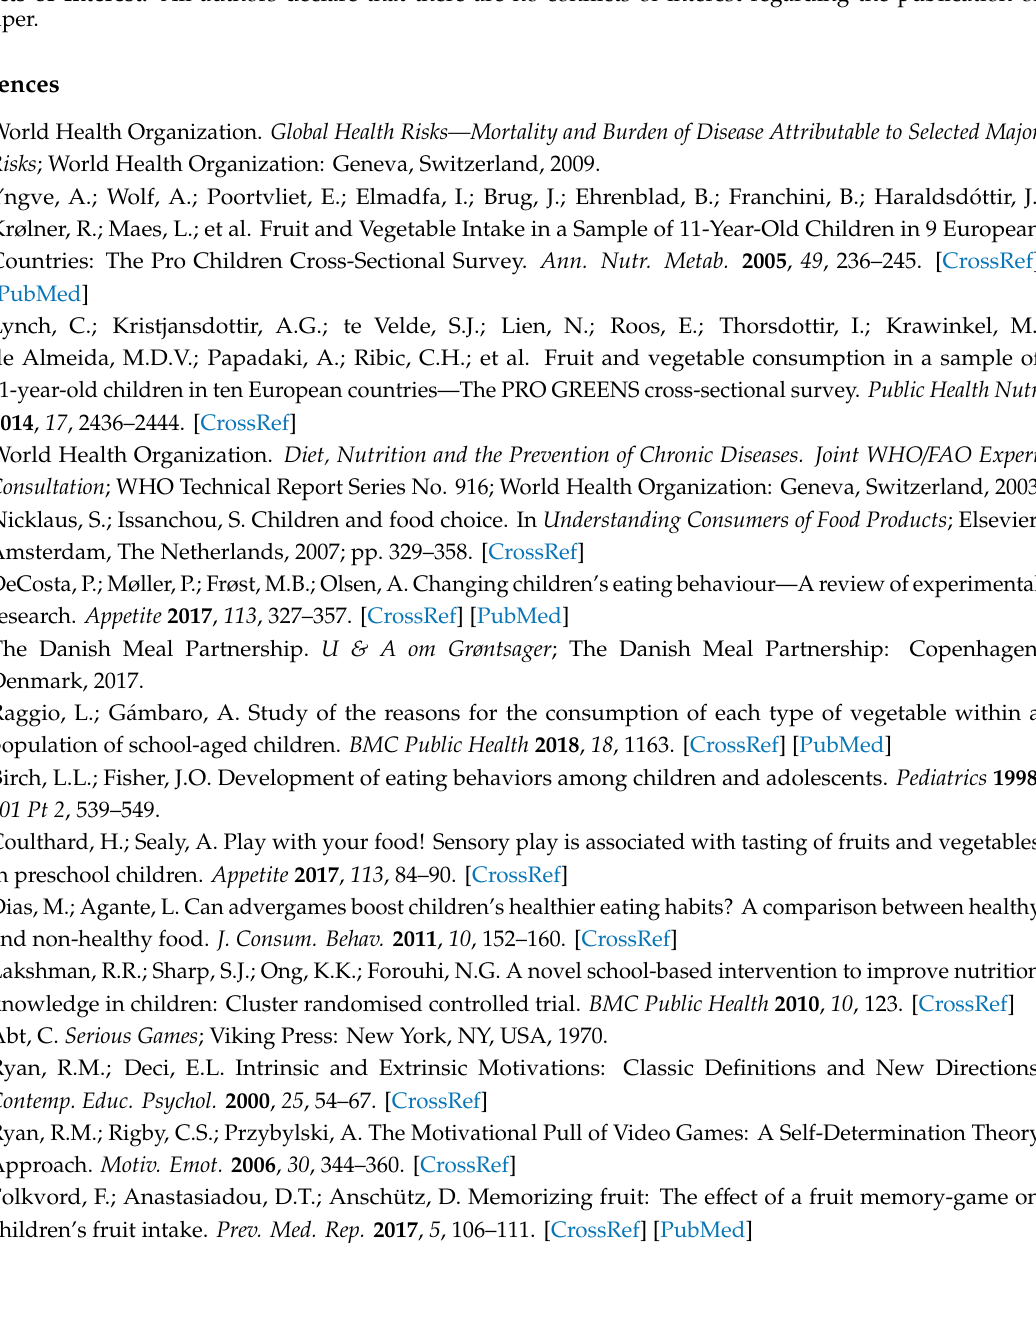
Table S1: Mean (SEM) number of words used to describe the six F&V in the baseline and follow-up test and significance in di ff erence for the treatment and age